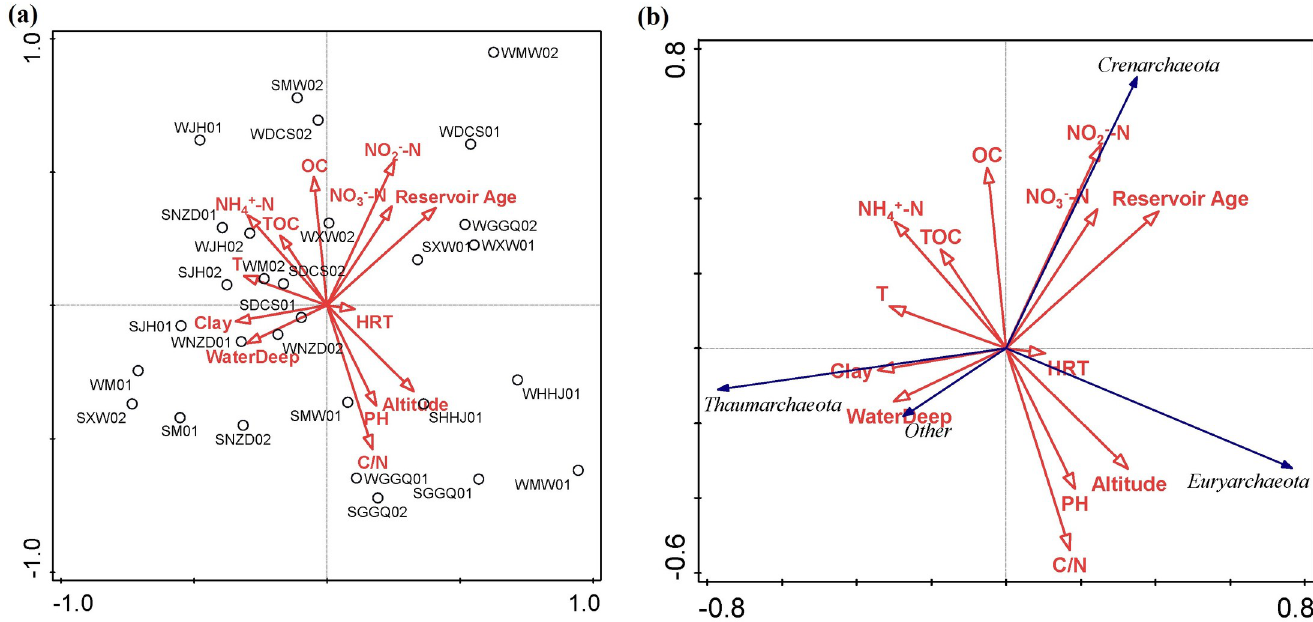
Fig 7. RDA ordination plot for the first two principal dimensions of archaeal communities and environmental